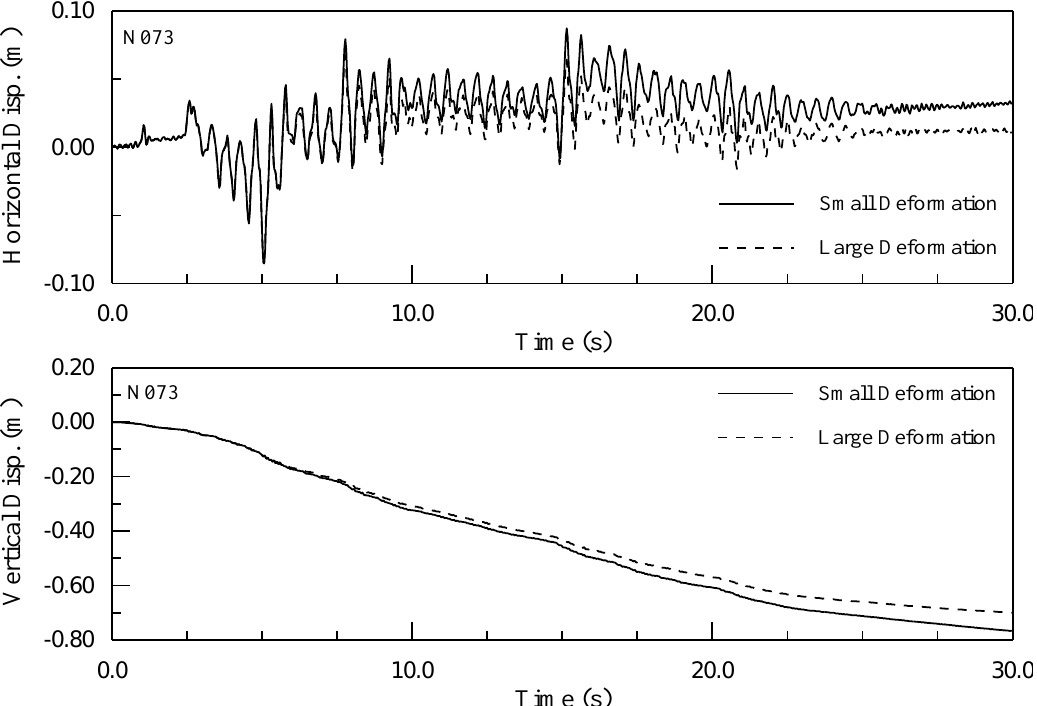
Figure 12. Horizontal and vertical displacement – time histories at node N073 — severe shaking.